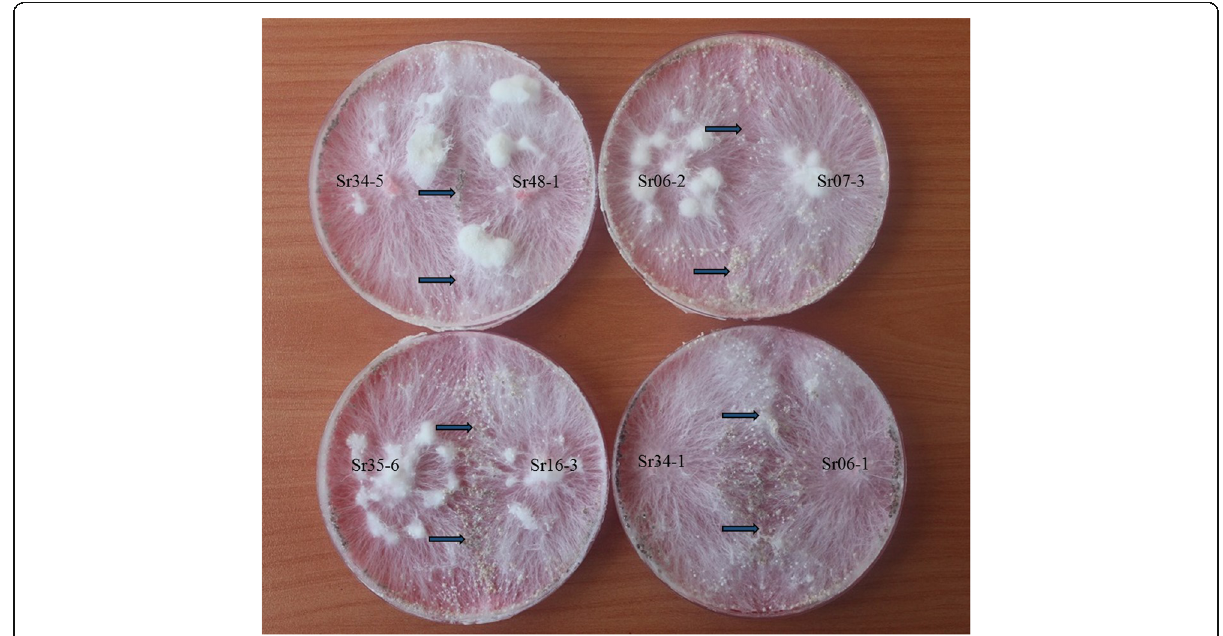
Fig. 2 Mycelial compatibility of some Sclerotium rolfsii isolates